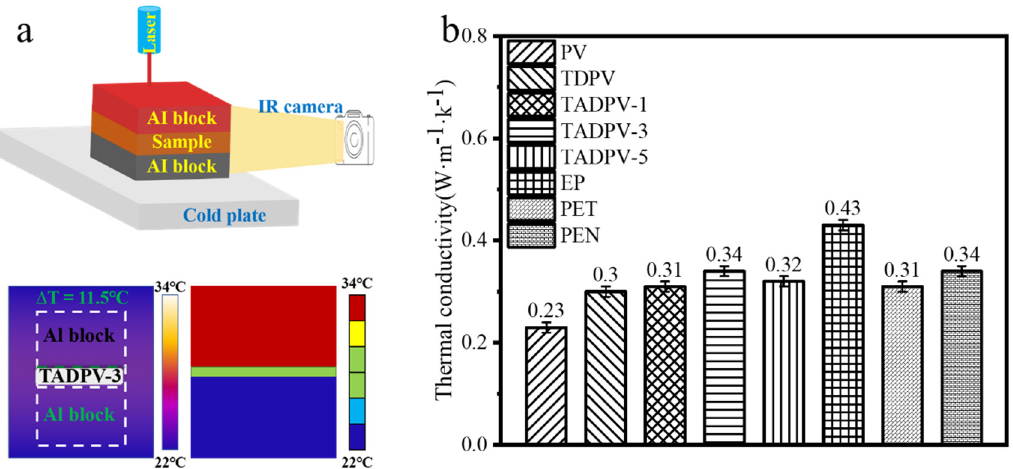
Figure 7. Thermal conductivity testing equipment and the coefficient of thermal conductivity of all specimens for the ( a ) thermal-conductivity measuring system, and ( b ) the comparison of all TADPVs and plastic substrates used in flexible electron devices.